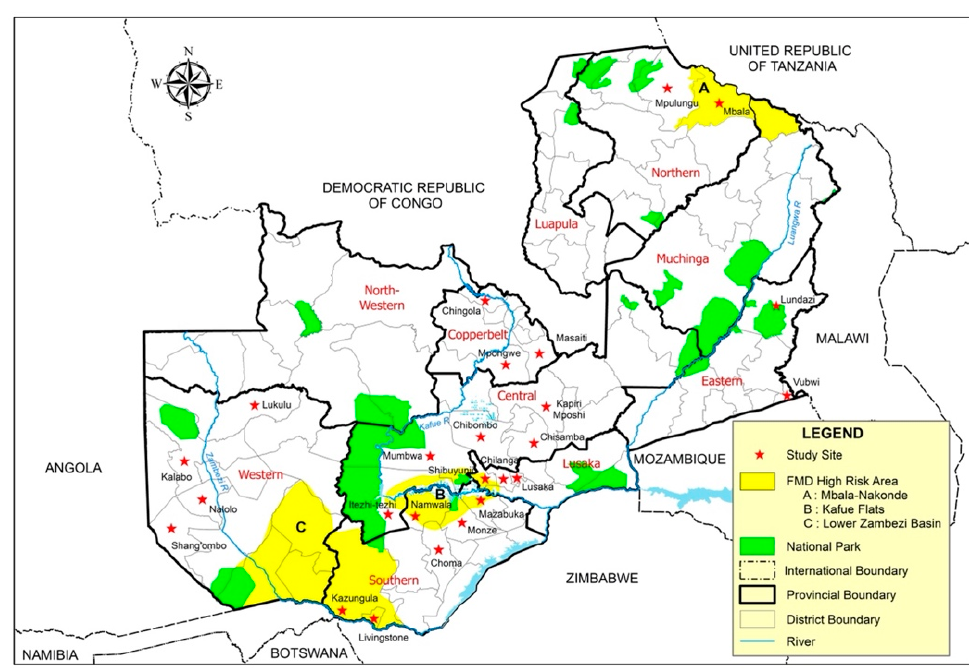
Figure 1. Foot-and-mouth disease high-risk areas and study sites in Zambia.